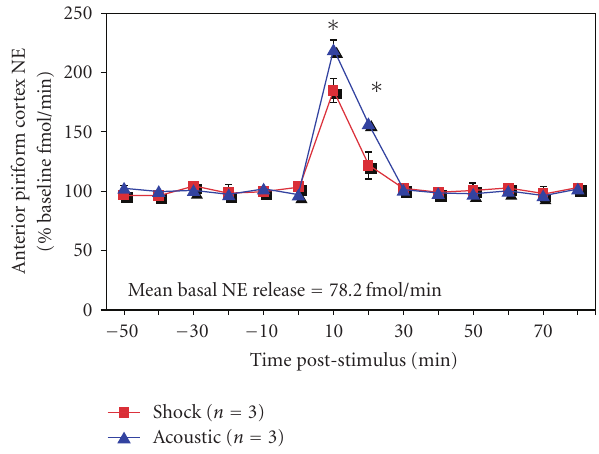
Figure 1: HPLC analysis of microdialysis samples taken from the anterior piriform cortex showed a significant increase in NE content following either siren stimulation as used here, or for comparison, footshock. This increase lasted at least 20